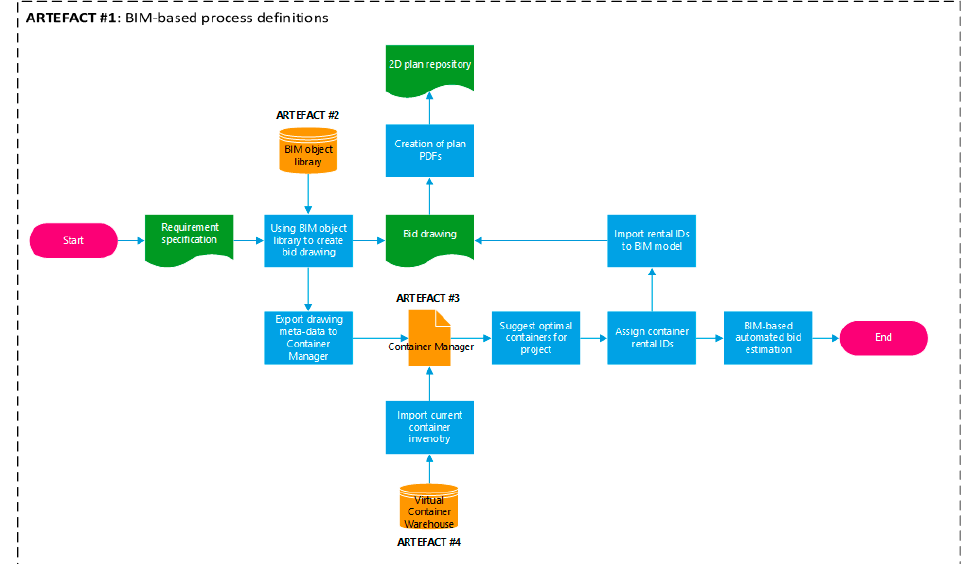
Figure 14. Interplay of the artefacts (= artefact #1).